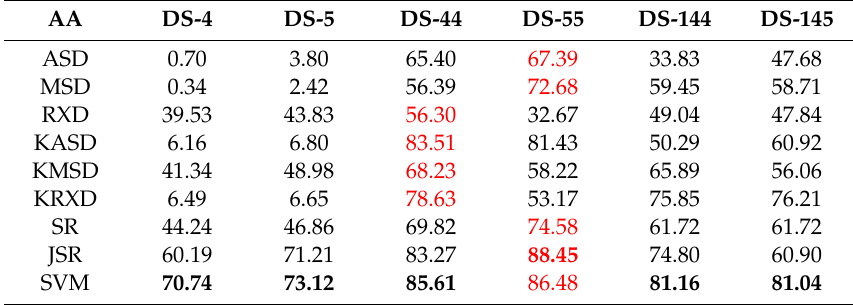
Table 4. Average accuracy (AA) in percentage of each method and band combination. Red numbers indicate the best accuracy for each method and bold numbers indicate the best accuracy for each dataset.